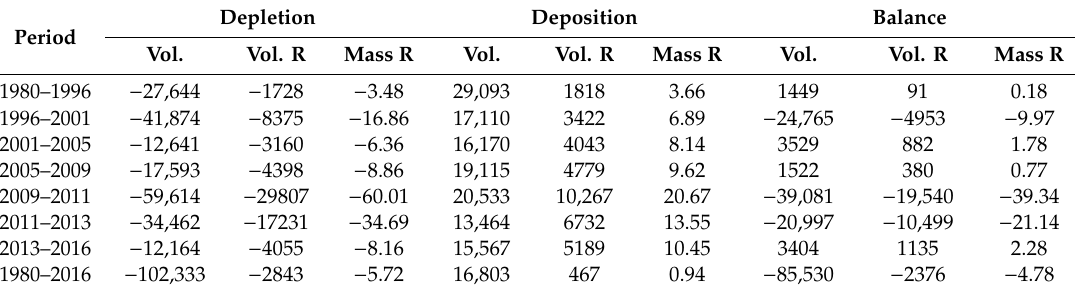
Table 7. Volumes and rates in the gullies of the whole study area 1,2,3